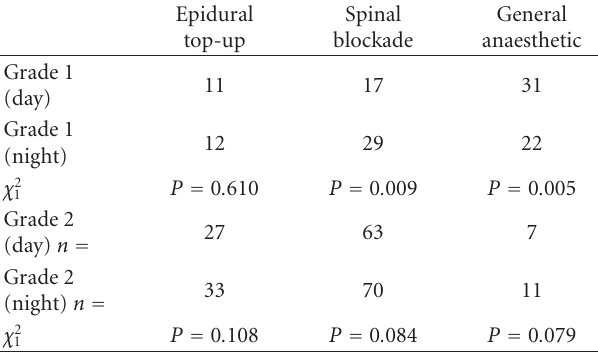
Table 2: Form of anaesthetic for grade 1 and grade 2 caesarean sections. Denominator data for analyses included 2620 women giving birth in daytime hours (excluding elective caesarean sections) and 2547 women giving birth